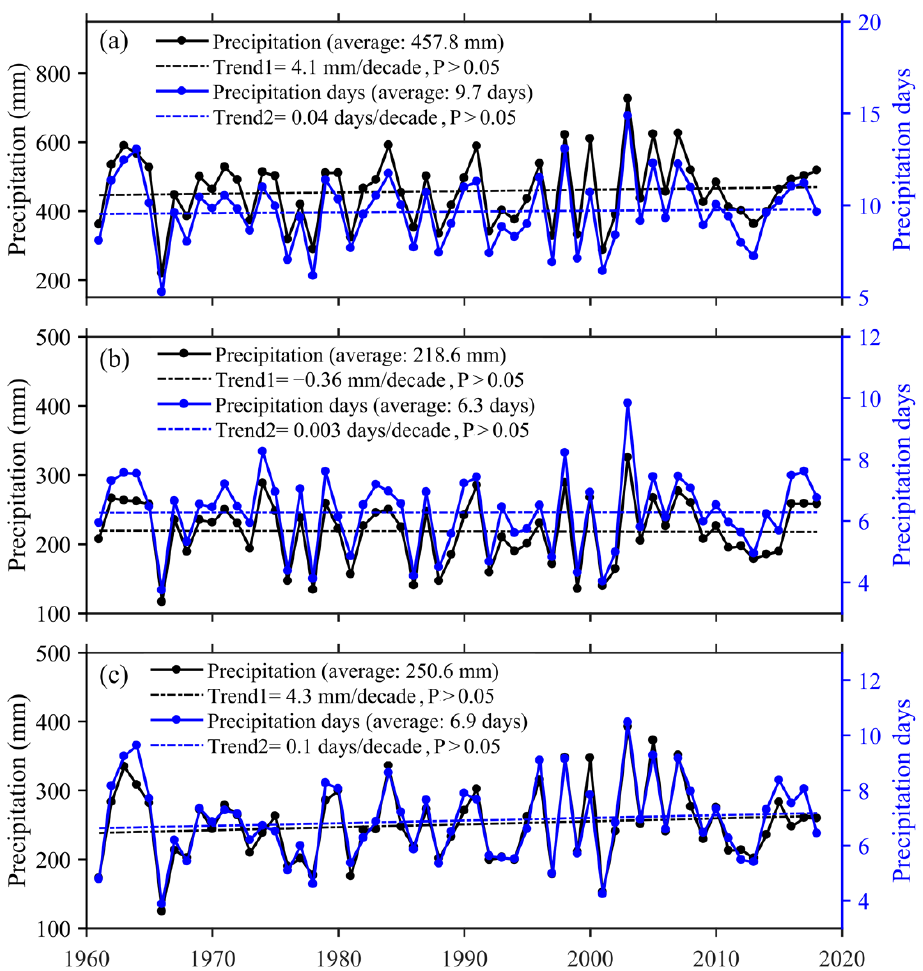
Figure 12. Annual variations in ( a ) TR90p, ( b ) DR90p, and ( c ) NR90p.